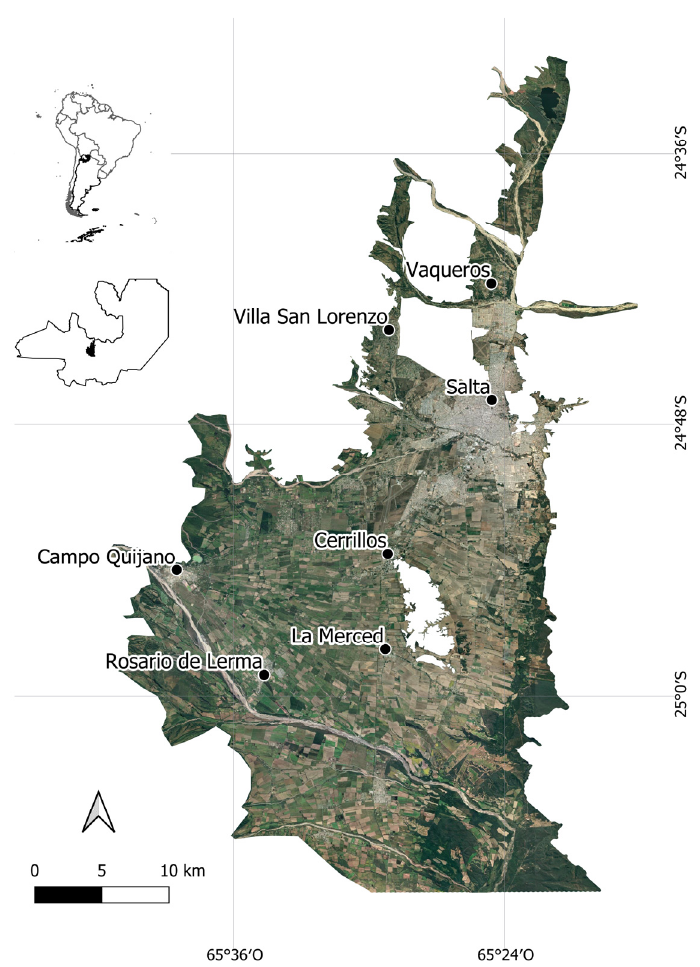
Figure 1. Metropolitan area of Lerma Valley with the detailed location of different towns (black points). On the top left is shown the specific location of the province of Salta and the study area.